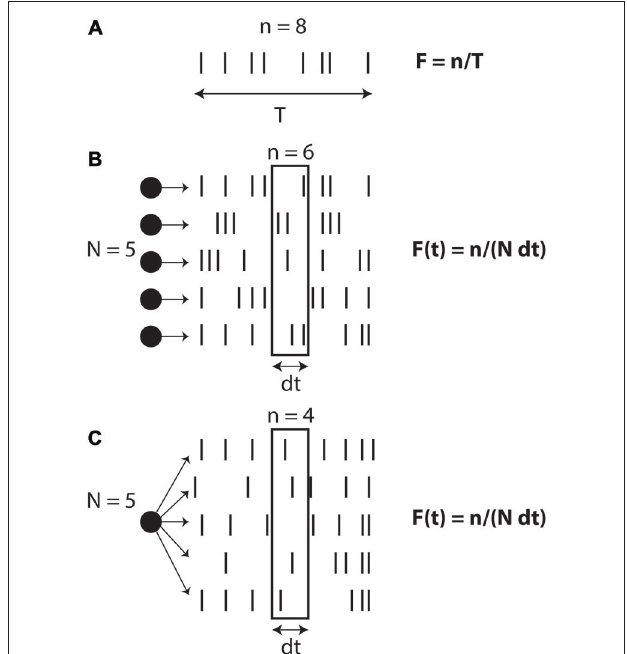
FIGURE 1 | Definitions of firing rate . (A) Rate as a temporal average (number of spikes n divided by observation time T). (B) Rate as a spatial average over N neurons, on a short time window dt. (C) Rate as a probability of firing, corresponding to an average over N trials for the same